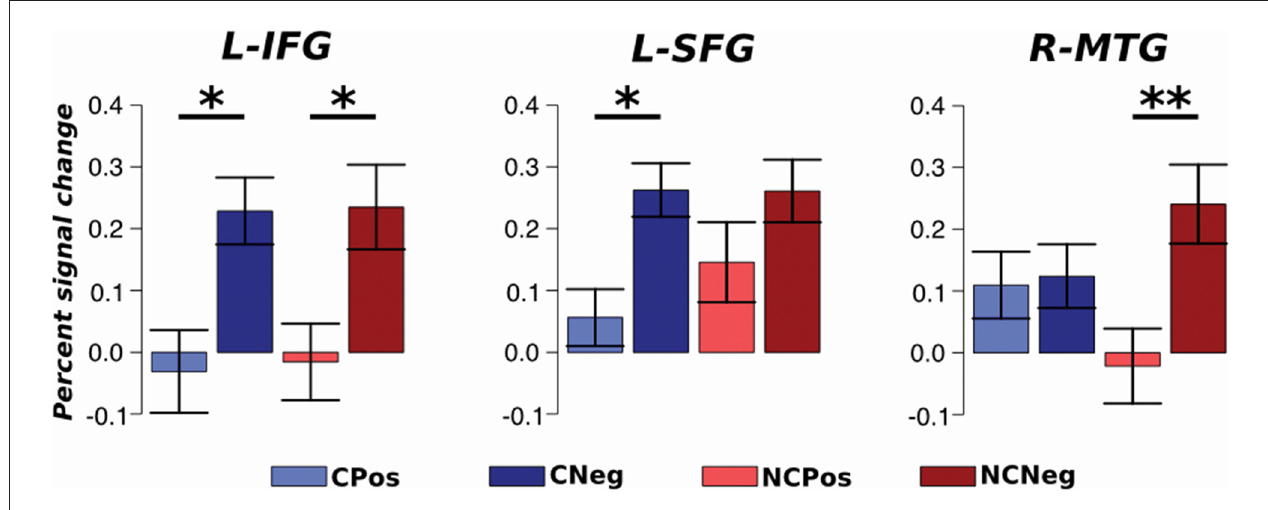
FIGURE 8 | Region of interest (ROI) analysis. Average activation with standard error for each ROI; left SFG (L-SFG) and L-IFG. ∗ p < 0.05 and ∗∗ p <